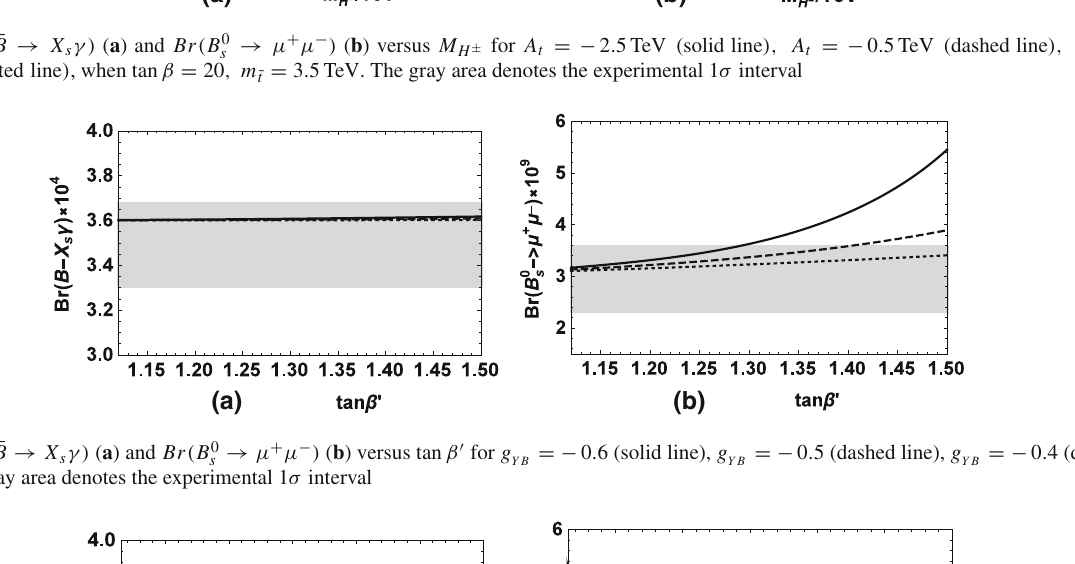
Fig. 9 Br ( ¯ B → X s γ) ( a ) and Br ( B 0 s → μ + μ − ) ( b ) versus tan β (cid:5) for g line). The gray area denotes the experimental 1 σ interval